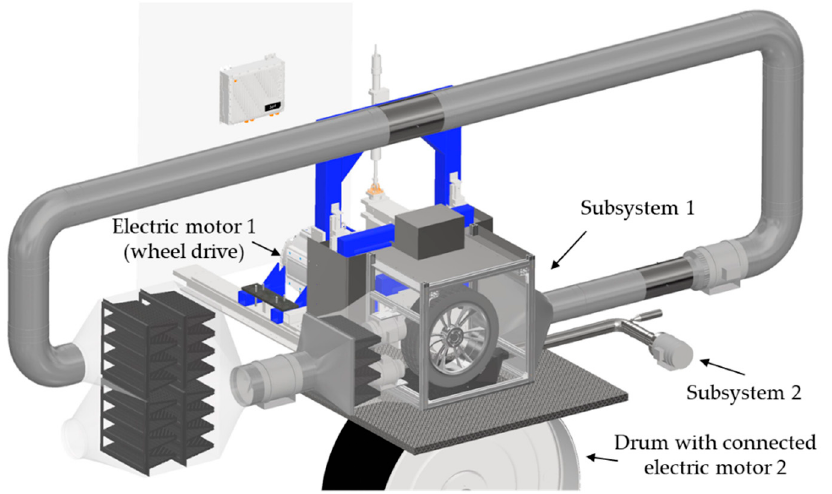
Figure 11. Test setup for the analysis of abrasion rate and PM emission factors on the single-roller test bench.